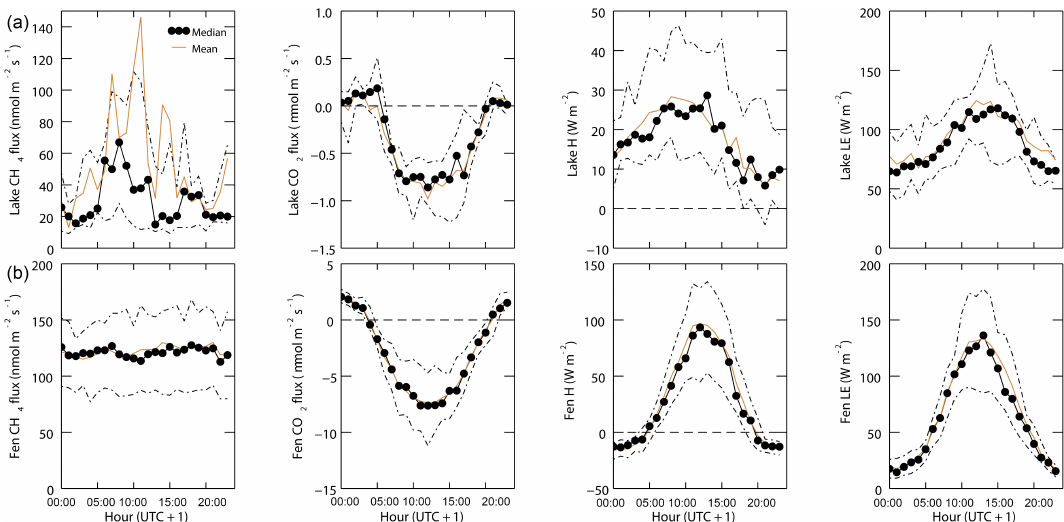
Figure 8. Diel medians, mean and 25th–75th percentiles of CH 4 fluxes, CO 2 fluxes, sensible heat flux ( H ) and latent heat flux (LE) measured at the lake (a) and at the fen (b) from June to August over the three ice-free seasons.